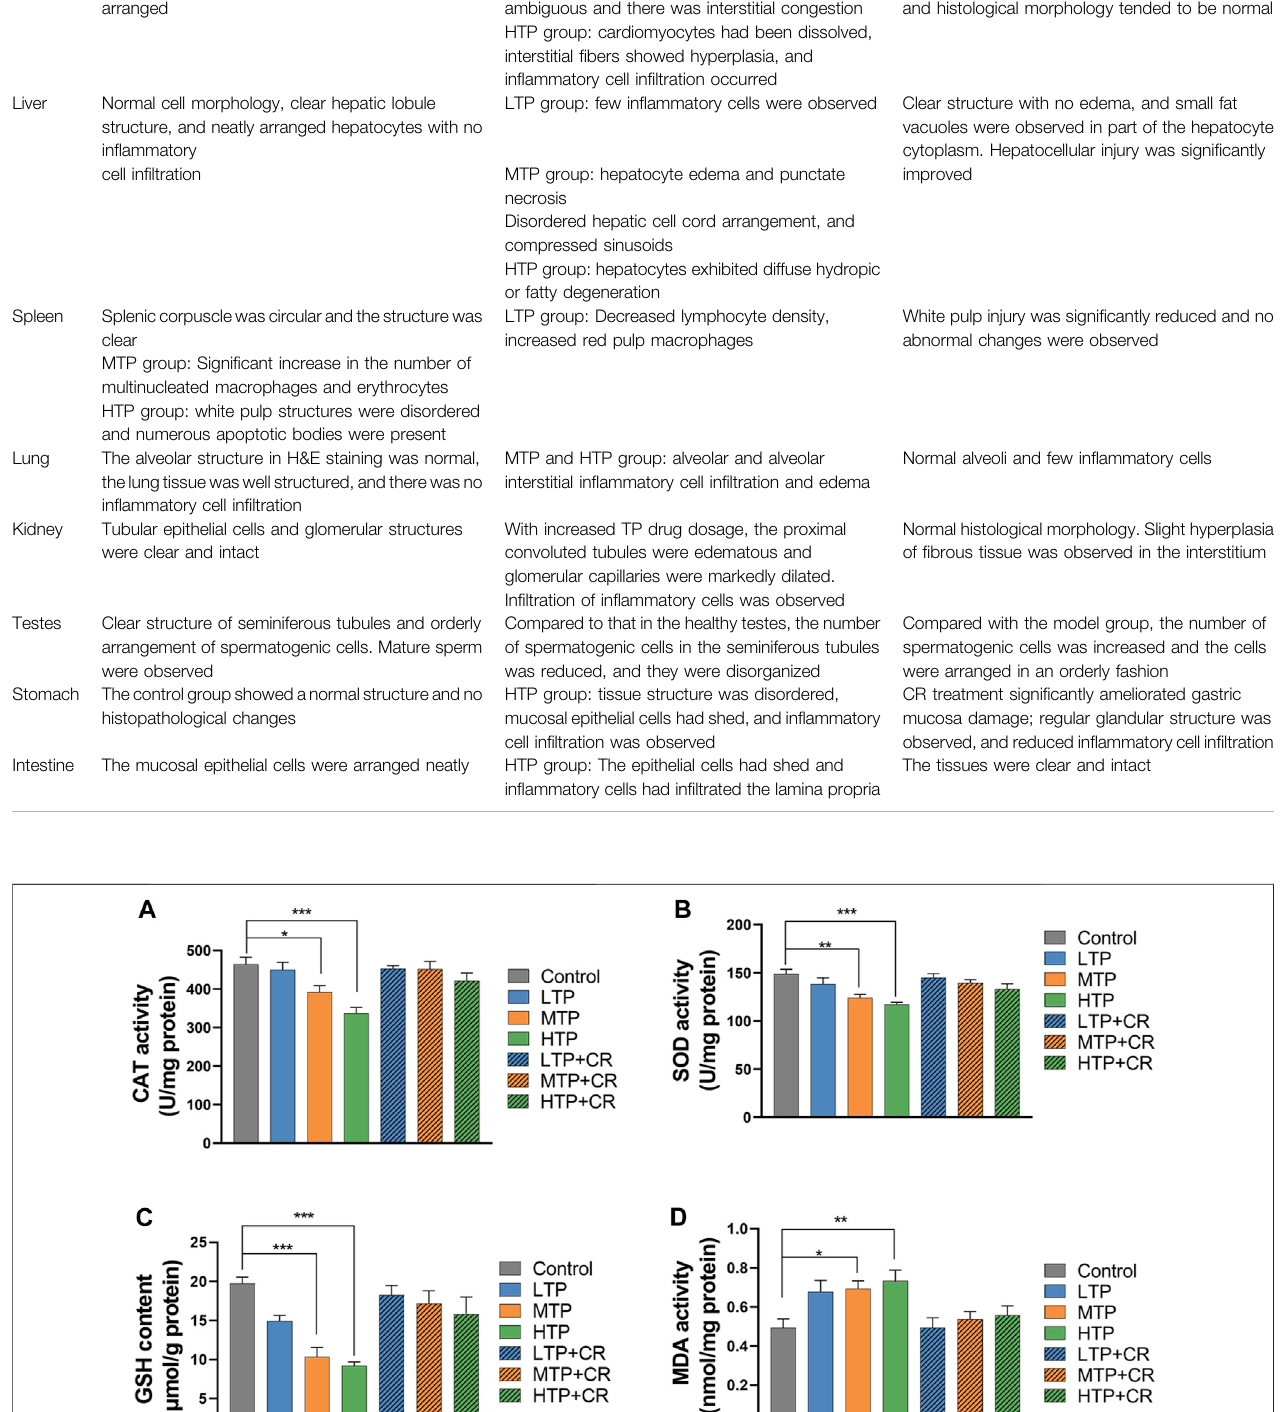
Frontiers in Pharmacology |